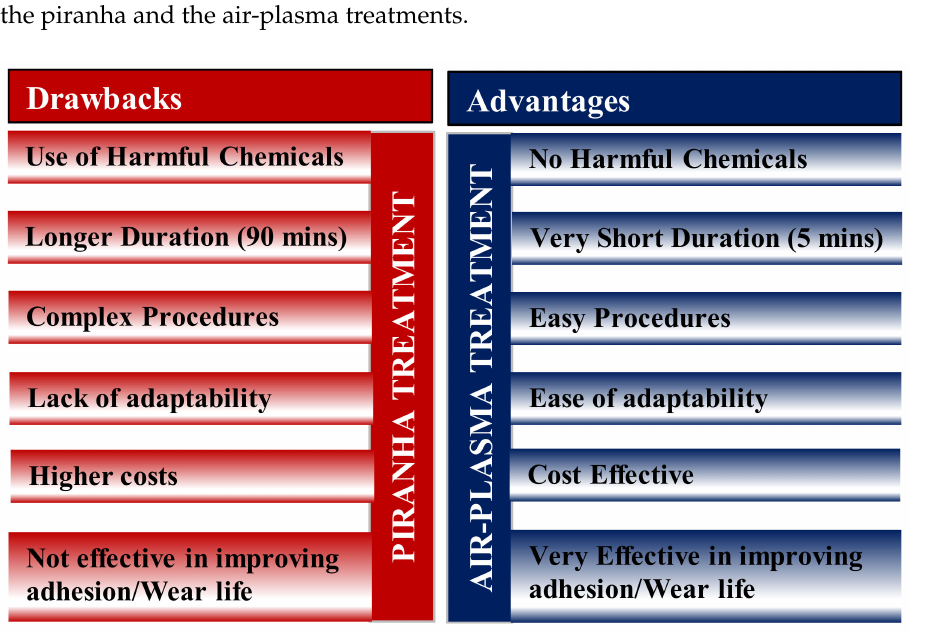
Figure 8. Drawbacks of the Piranha Treatment as compared to the Advantages of the Air-Plasma